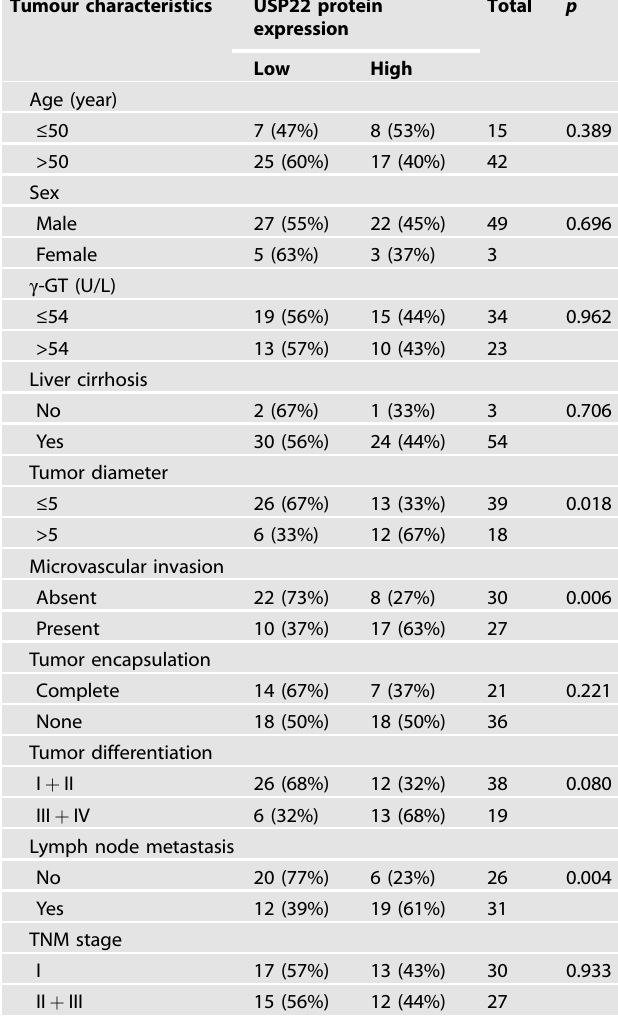
Correlation of USP22 protein expression with clinicopathology in 57 CCA in 2nd Hospital of Dalian Medical University, China. γ -GT γ -glutamyl transferase, TNM tumour-nodes metastasis. p -value was calculated using the Pearson χ 2 test, and p < 0.05 was considered a statistically signi fi cant